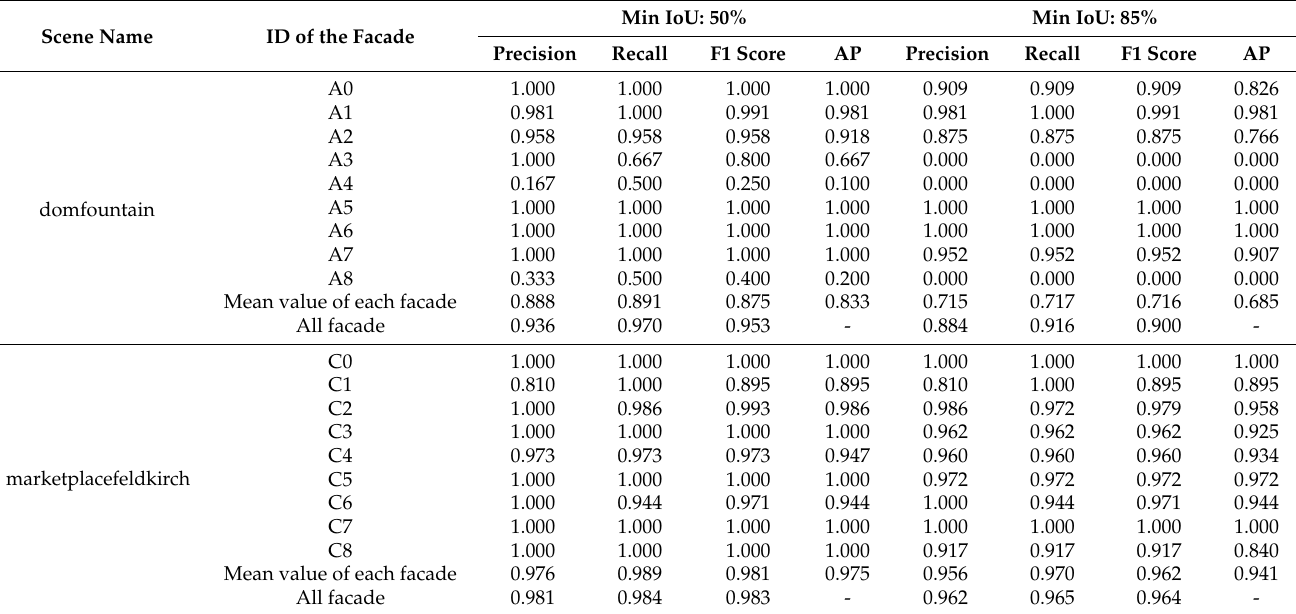
Table 4. Accuracy of window extraction for Semantic3D.Net Benchmark